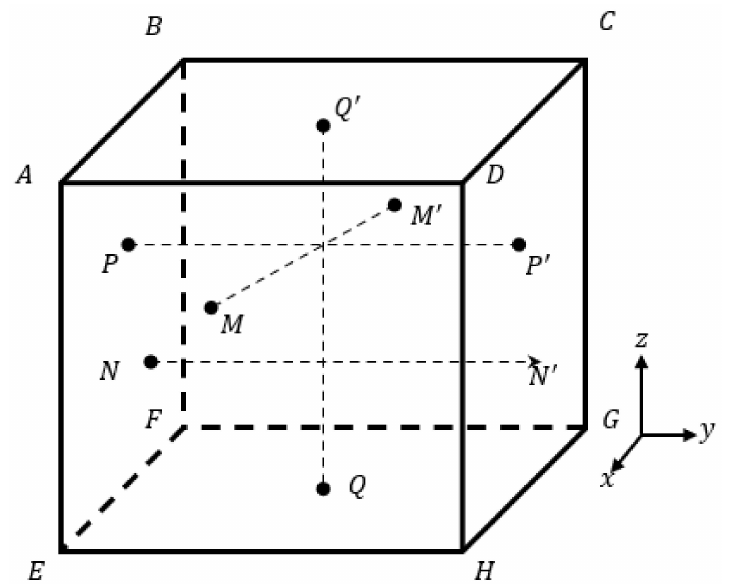
Figure 7. Boundary conditions for multipoint constraint